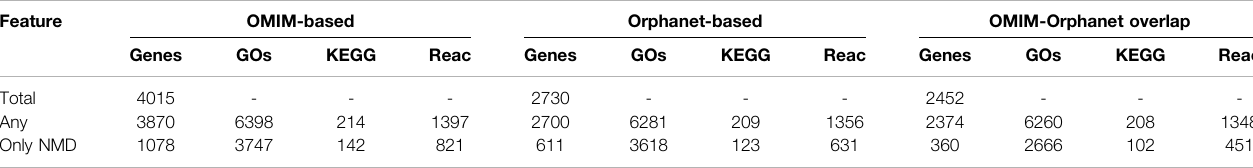
TABLE 4 | Numbers of genes and functions associated with phenotypes. Total: all genes in each dataset. “ Any ” : genes/functions associated with any phenotype. “ Only NMD ” : genes/functions associated with a typical NMD phenotype. Feature